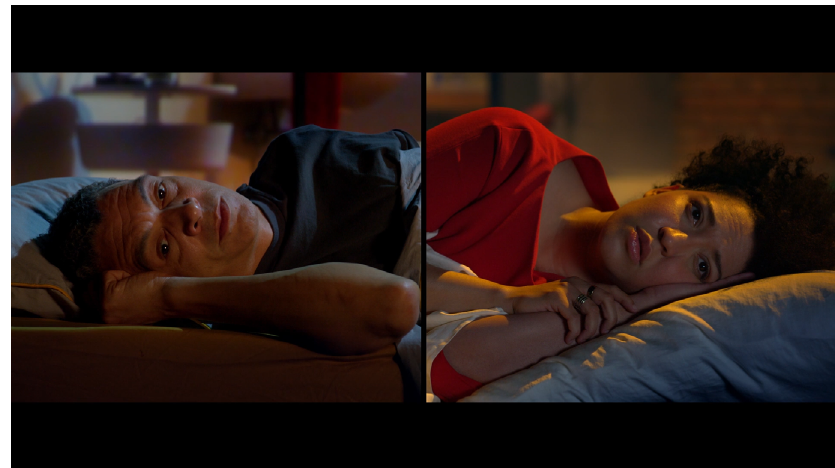
Fig. 2 – Roderick Williams and Julia Bullock as father and daughter. Michel van der Aa, Upload , still